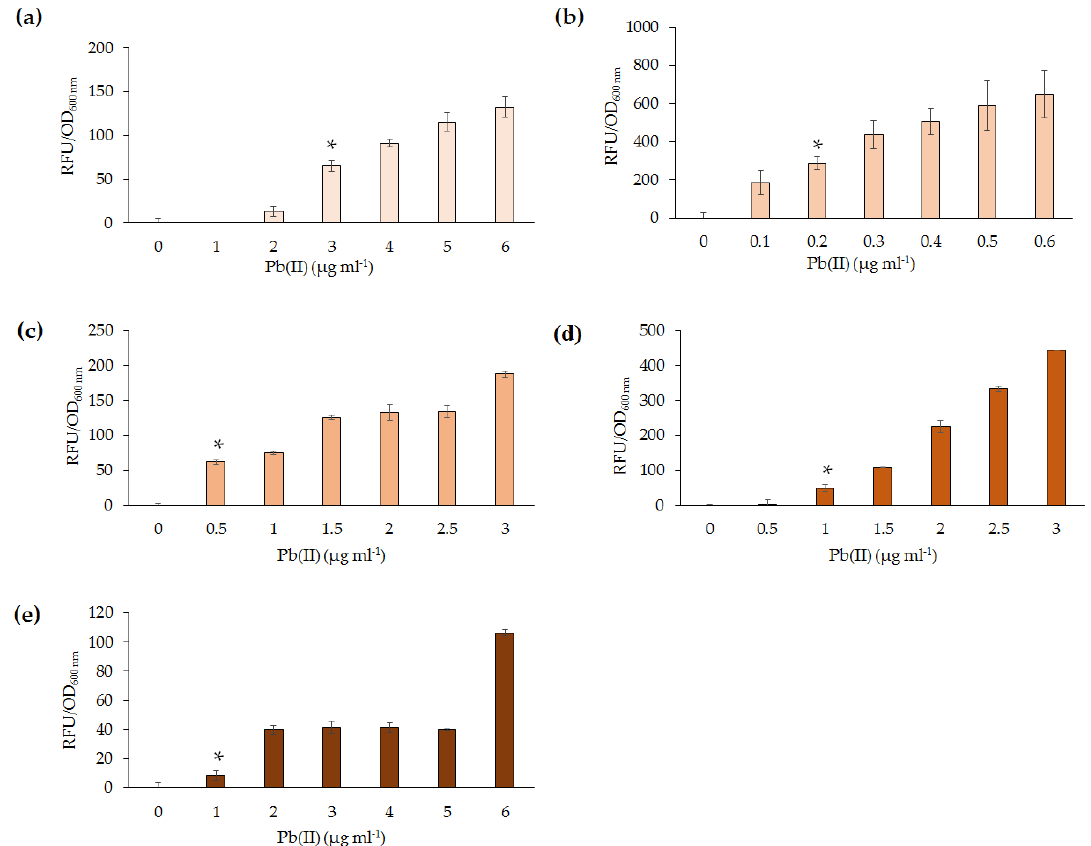
Figure 3. The limit of detection was determined to range between 0.2 and 2 µg·mL −1 Pb(II) for the developed lead biosensors (* p < 0.05). The p -value indicates a significant increase in RFU per OD 600 nm ,